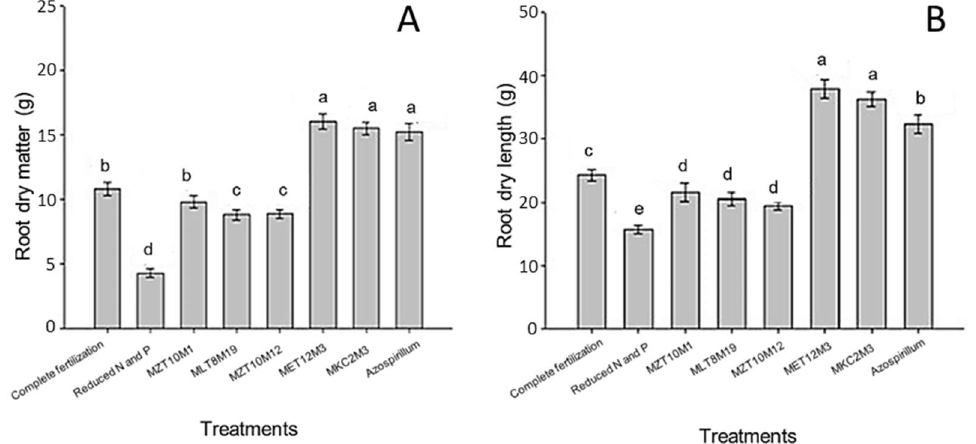
Figure 10. Root dry matter ( A ) and root length ( B ) in uninoculated plants and plants inoculated with in vitro selected endophytic bacteria. Means represented by the same letter do not differ significantly by the Scott–Knot test at 5% probability.